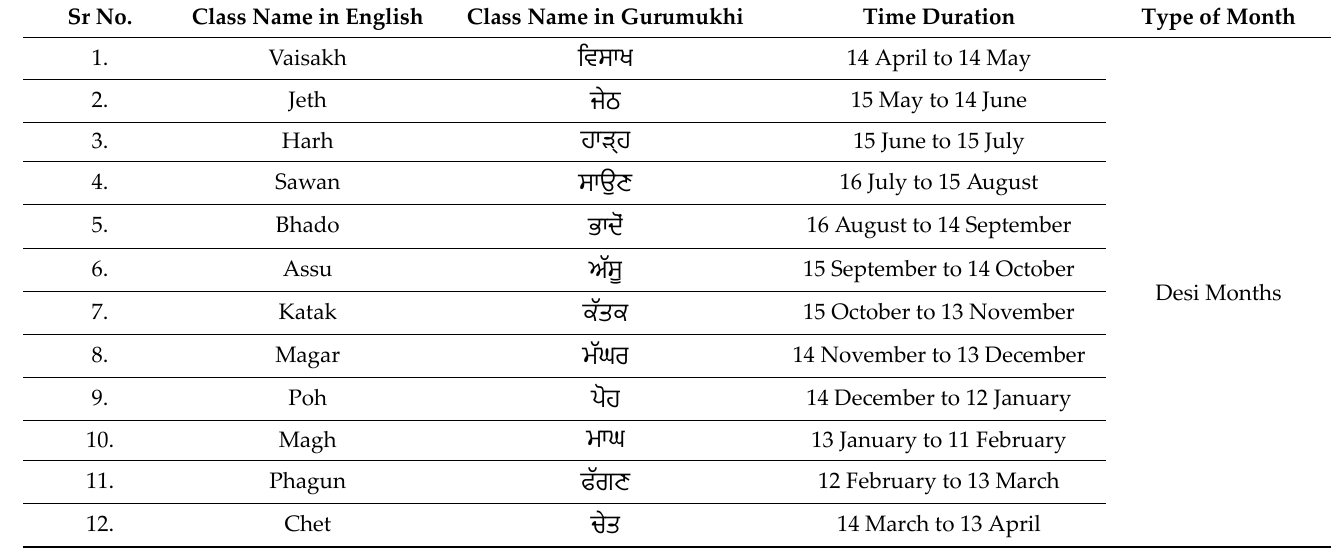
Table 1. Detail overview of dataset.